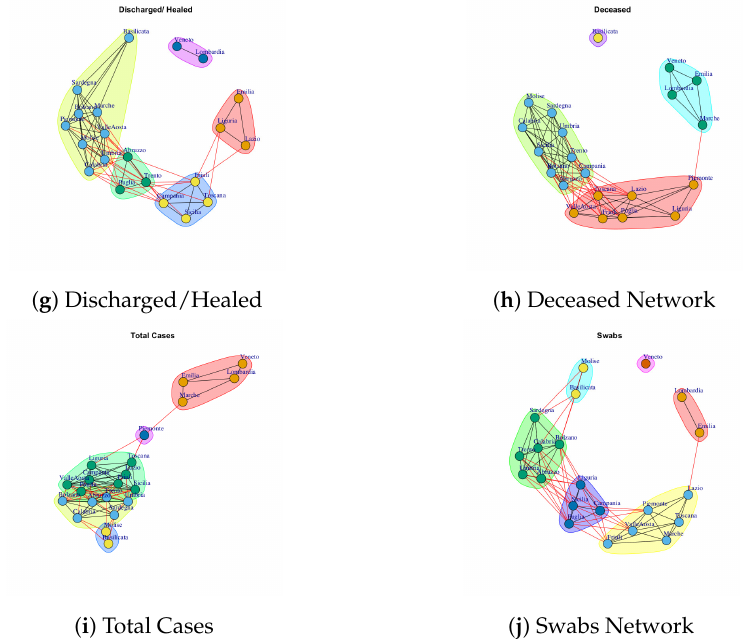
Figure 13. The figure shows the communities identified in Italian COVID-19 networks in the study